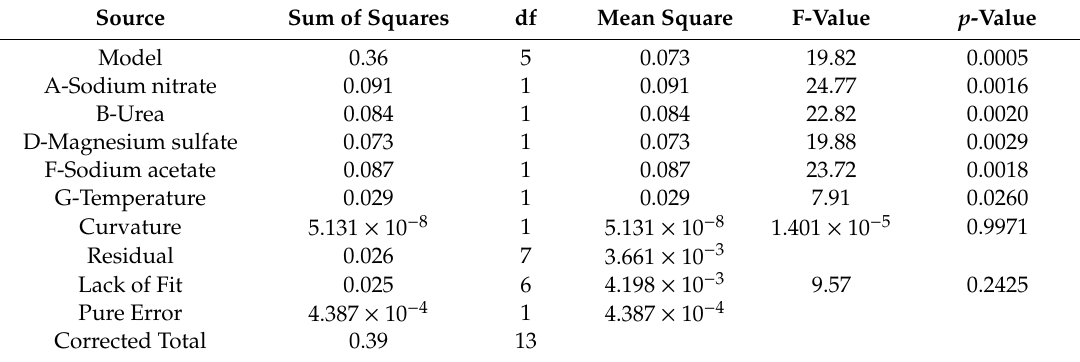
Table 3. ANOVA of the reduced model from PBD screening for CaCO 3 precipitates concentration. Source Sum of Squares df Mean Square